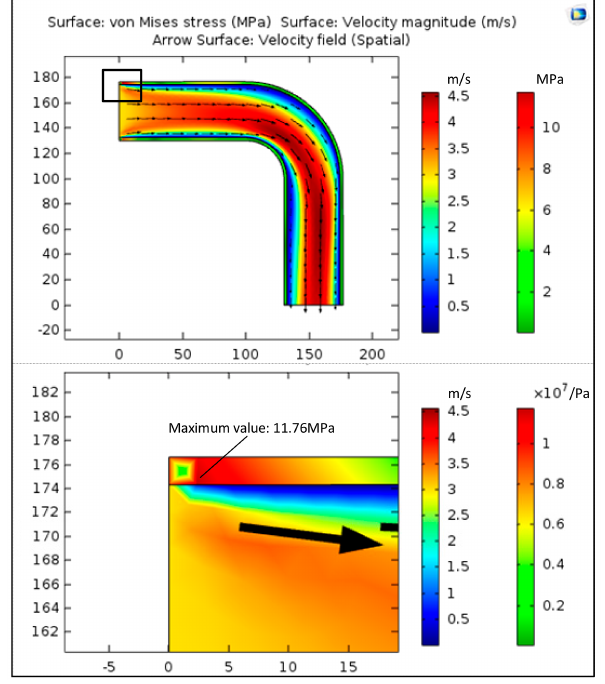
Figure 3. The stress field of copper bending pipe in initial state.